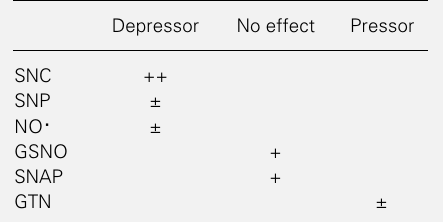
donors injected into the